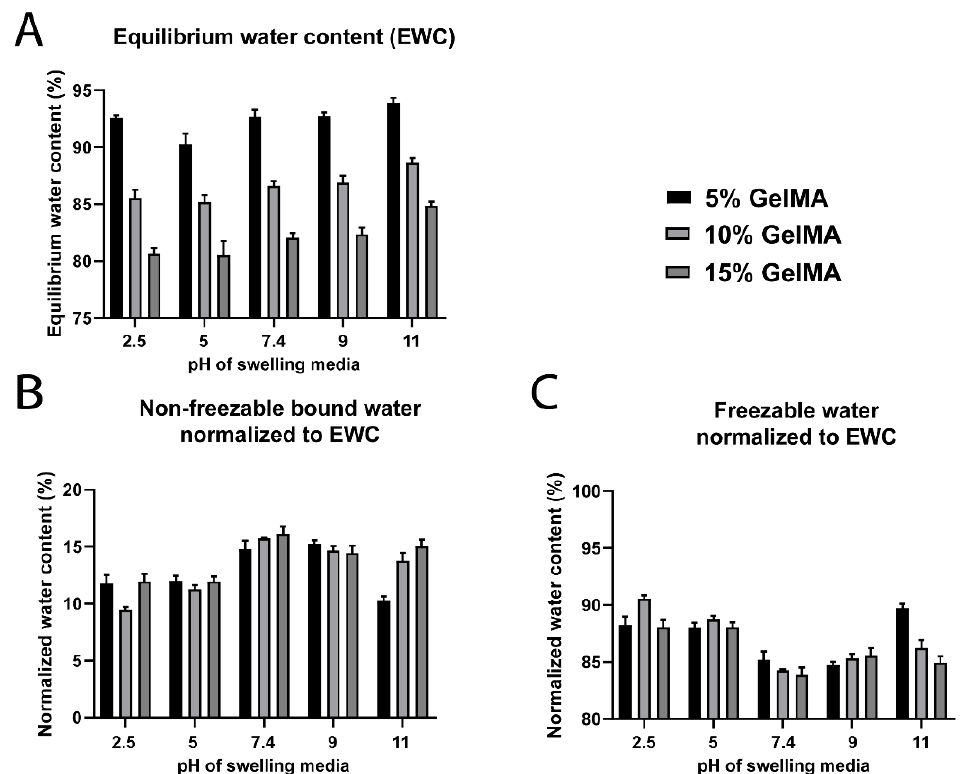
Figure 7. Water content and water types for GelMA hydrogels (5% to 15% gel fraction) crosslinked in water and swelled in media of different pH and fixed ionic strength of 150 mM. ( A ) Equilibrium water content ( EWC , n = 5). ( B ) Non-freezable bound water ( W nfb ) normalized to the EWC ( n = 3). ( C ) Freezable water ( W f ) normalized to the EWC ( n = 3).